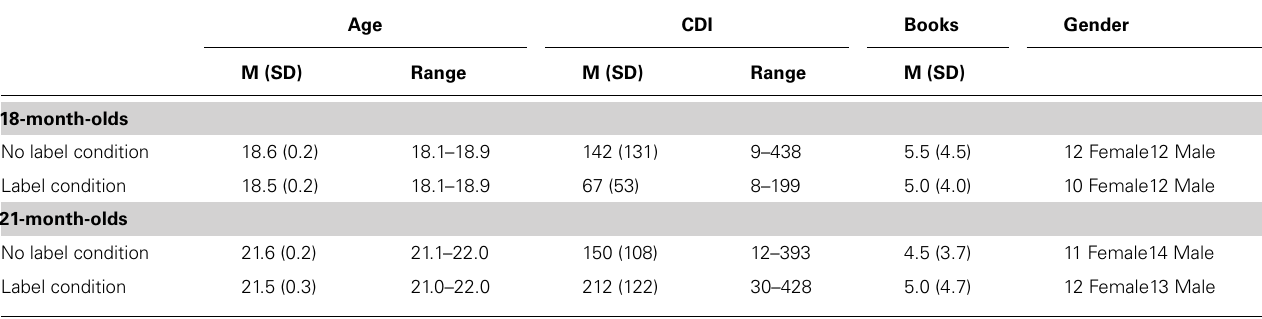
Table 1 | Infant demographic information as a function of age and